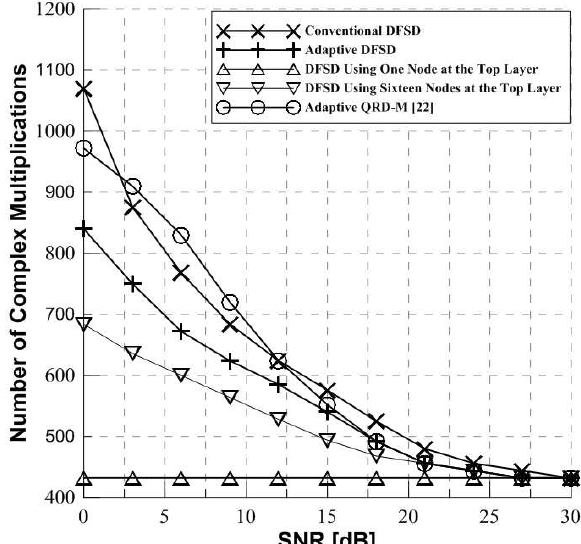
Figure 12. The complexity of the detection schemes in 2 × 2 MIMO-OFDM system with